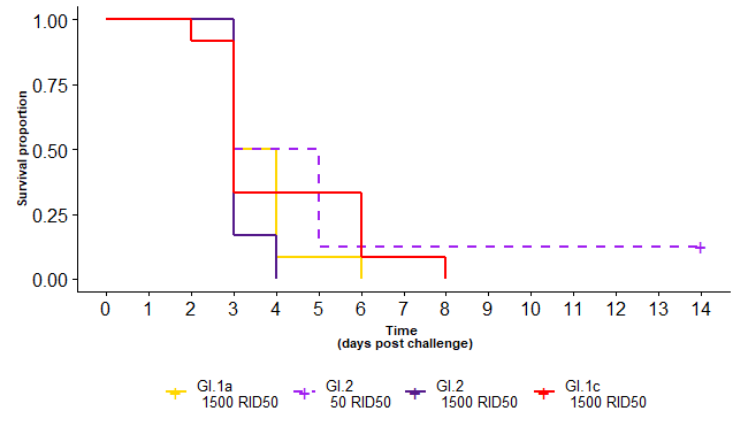
Figure 2. Survival curve of seronegative rabbits after challenge with GI.1c (red), GI.1a (yellow) or two different doses of GI.2 (purple-dashed, dark purple). For seronegative rabbits, there was no statistical difference in survival between the variant used nor the infectious dose.